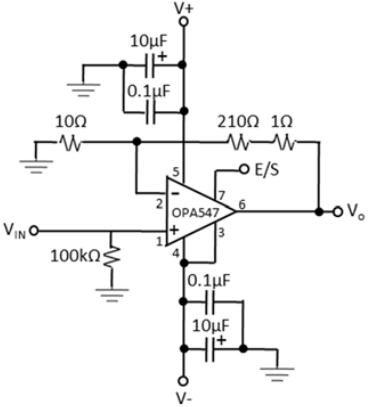
Figure 3. The electronics for the electromagnetic driving mechanism.